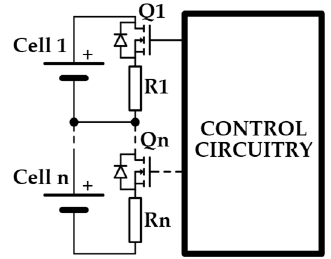
Figure 1. Block diagram of balancing circuit.